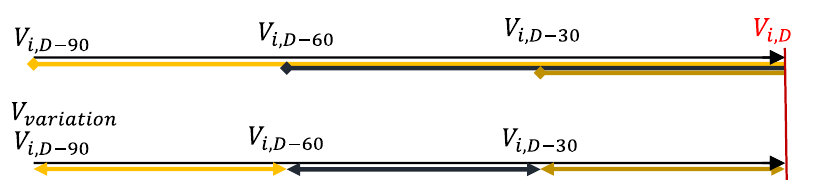
Fig. 2 Date selection of discussion volume in this